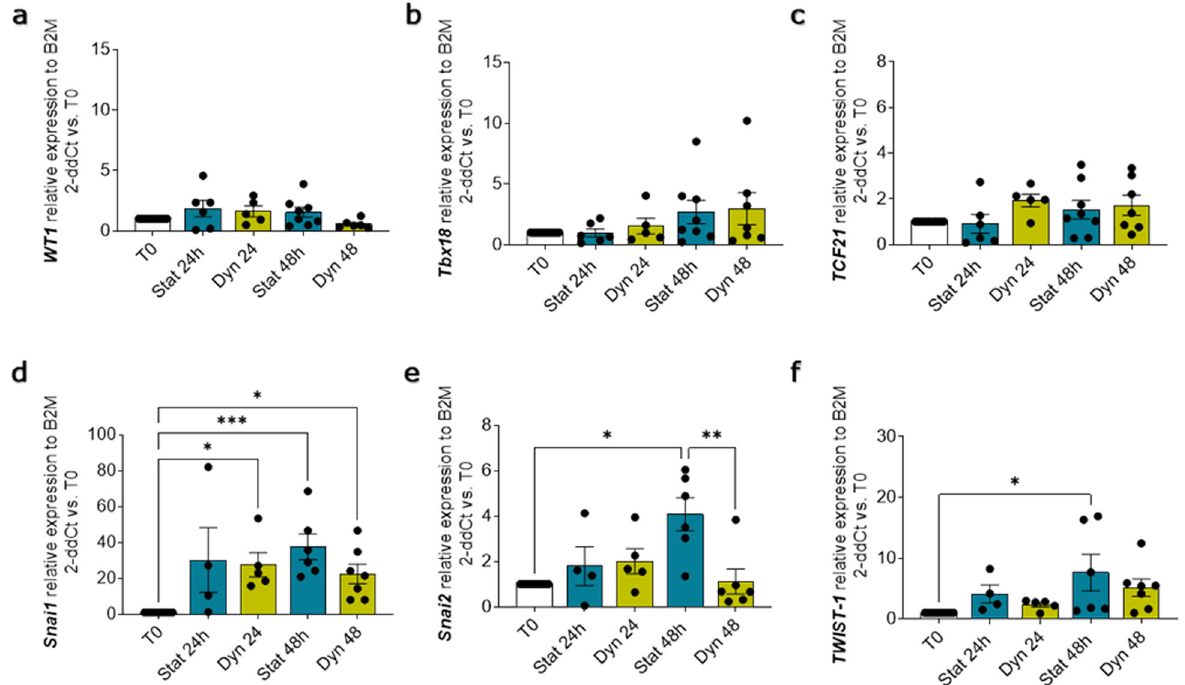
Fig. 6 Epicardial and EMT gene expression in culture. Relative gene expression in the whole slice evaluated qPCR: expression of WT1 ( a ), Tbx18 ( b ), and TCF21 ( c ) show no change in either static (Stat) or dynamic (Dyn) culture, relative to basal expression at T0. EMT markers Snai1 ( d ) signi fi cantly increased in both culture conditions. Snai2 ( e ) and TWIST-1 ( f ) remained unchanged by the dynamic culture system but was upregulated in static when compared to freshly cut slices (T0). N of pigs = 3 – 7, number of slices displayed in the graph. All graphs display data as mean ± SEM. * p ≤ 0.05, ** p ≤ 0.01, *** p ≤